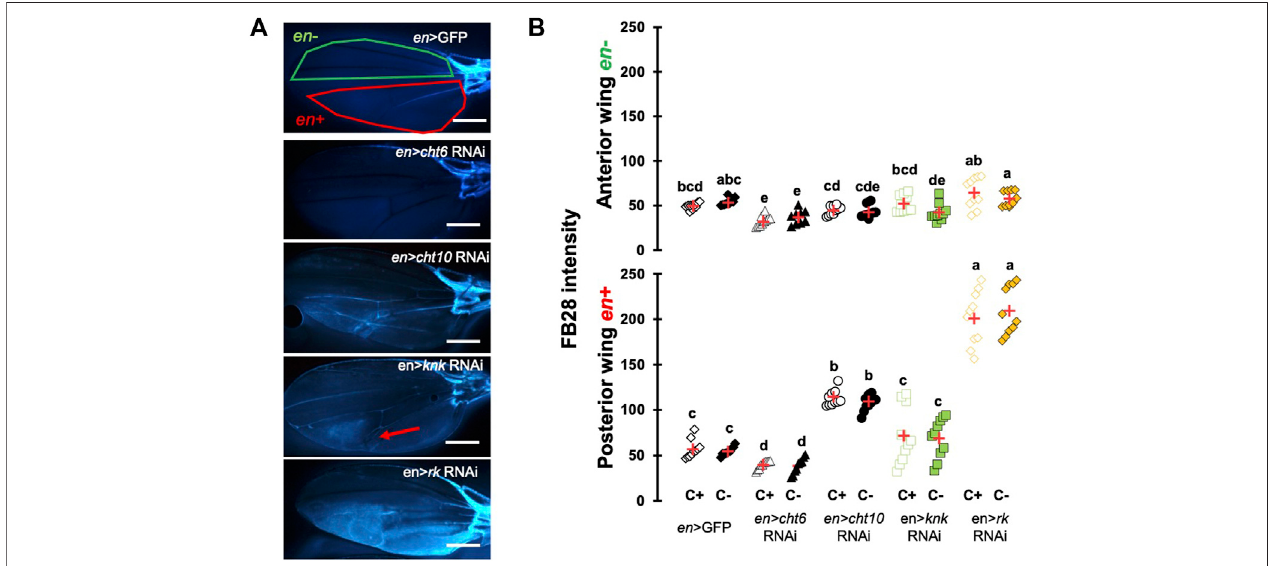
FIGURE 2 | FB28 hot staining combined with transgene differentially expressed in the wing reveal how speci fi c genes affect chitinous content. (A) 48 h-old female wings stained with FB28 (65 ° C during 60 min). Pictures were taken from fl ies prewashed with chloroform (C+) before staining. en -GAL4 was used to speci fi cally drive RNAi expression in the posterior half of the wing. Three chitin-related genes, chitinase 6 ( cht6 ), chitinase 10 ( cht10 ) and knickkopf ( knk ) were down-regulated. Additionally, the gene coding for the “ tanning-hormone ” receptor DLGR2 ( rk ) was down-regulated. Red line indicates the zone used for quanti fi cation of engrailed expressing zone ( en+ ). Green line indicates the zone used for quanti fi cation of engrailed non-expressing zone ( en- ). Red arrow in en > knk RNAi wing indicates a vein doubling in the en + area. Scale bar = 0.3 mm. (B) FB28 intensity quanti fi cation in en- zone (upper panel) and en + zone (lower panel). Data are represented as scattergrams showing all data points with the mean (red crosses). C+ and C- individuals are represented with empty and black fi lled markers respectively. Different marker shapes/colors represent the different genotypes. Different letters indicate statistically signi fi cant differences (one way Kruskall-Wallis test followed by a Conover- Iman procedure, p -value < 0.001). n = 10 in each